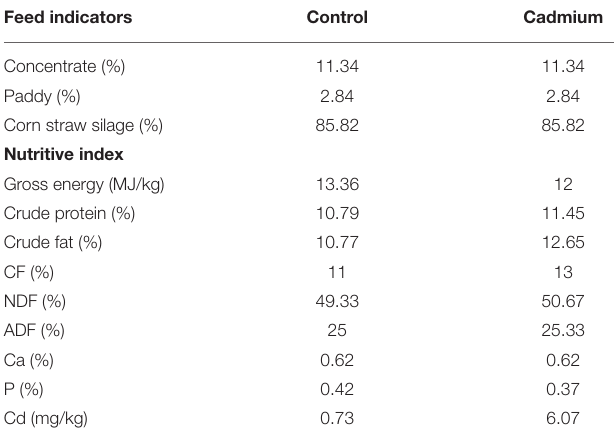
TABLE 1 | Feed formulation for the control group and cadmium-treated